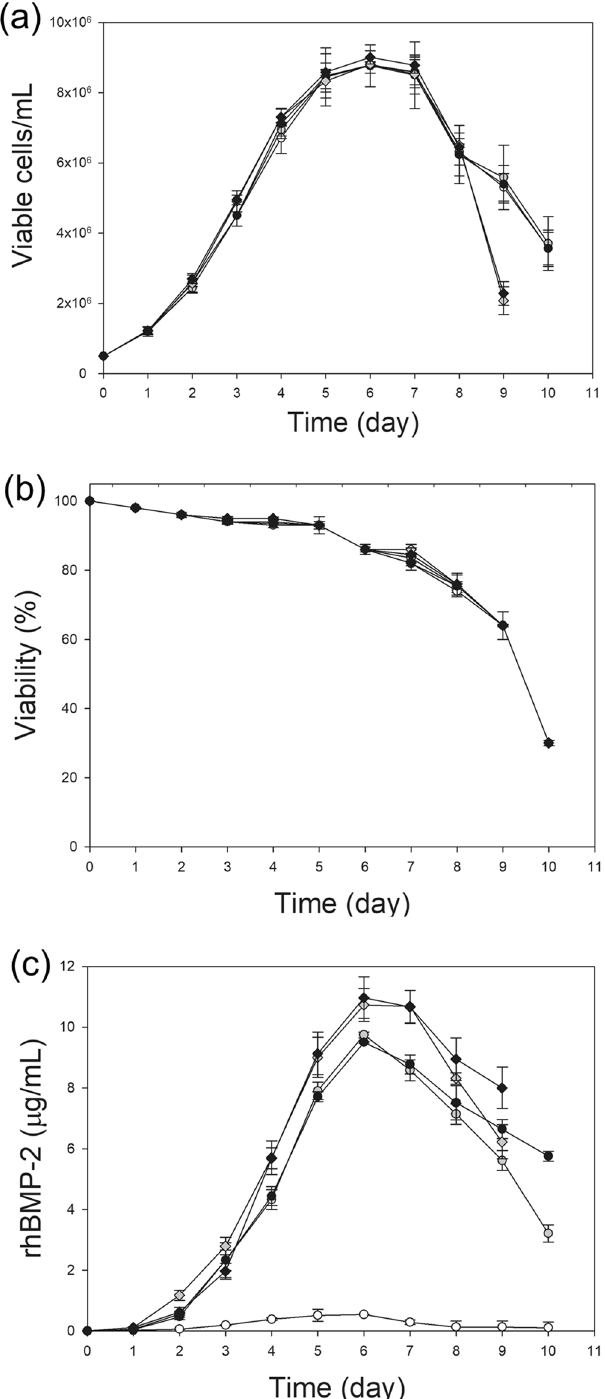
Figure 7. Supplementation of DS or heparin in CHO-BMP-2 cells cultures. Profiles of ( a ) cell growth, ( b ) viability, and ( c ) rhBMP-2 concentration during cultures supplemented with DS or heparin. No supplementation (white circle), supplementation with 0.1 g/L heparin (gray square), 0.2 g/L heparin (black square), 0.5 g/L DS (gray diamond), and 1.0 g/L DS (black diamond). The error bars indicate standard deviations calculated from the data of three independent